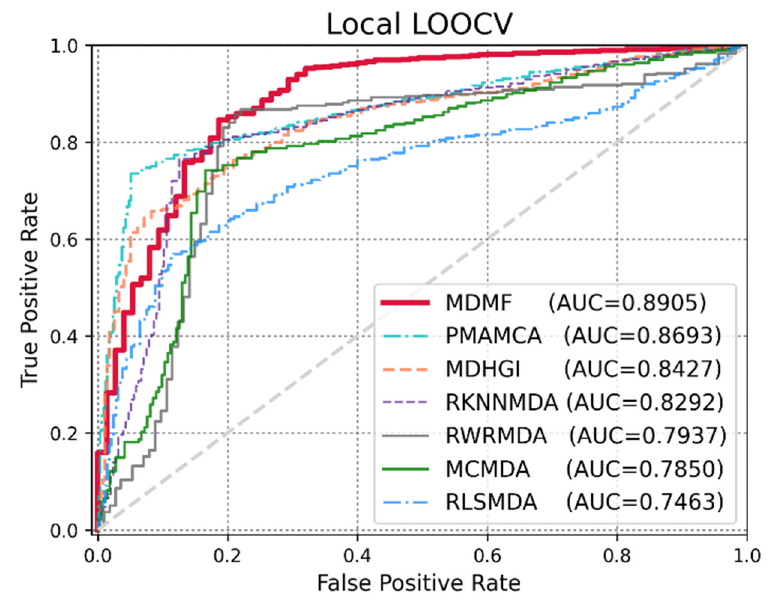
Figure 3. Performance comparisons between MDMF and five existing miRNA–disease association prediction models (MDHGI, PMAMCA, MCMDA, RLSMDA, and RKNNMDA) in terms of AUCs based on global LOOCV.